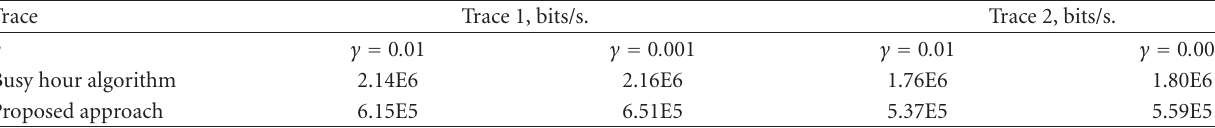
Table 1: Comparison with static busy hour bandwidth